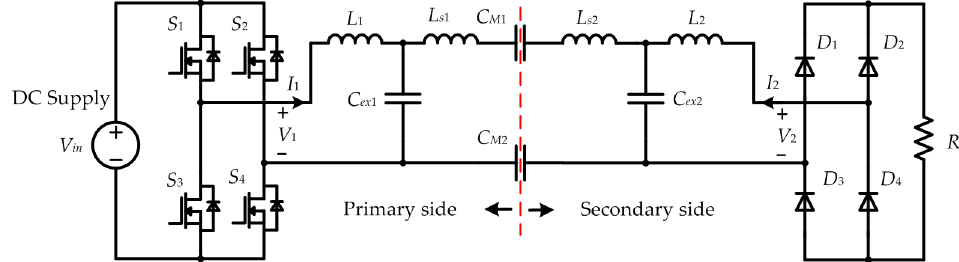
Figure 17. Circuit topology of a CPT system based on full-bridge inverter with double-sided LCL compensation.